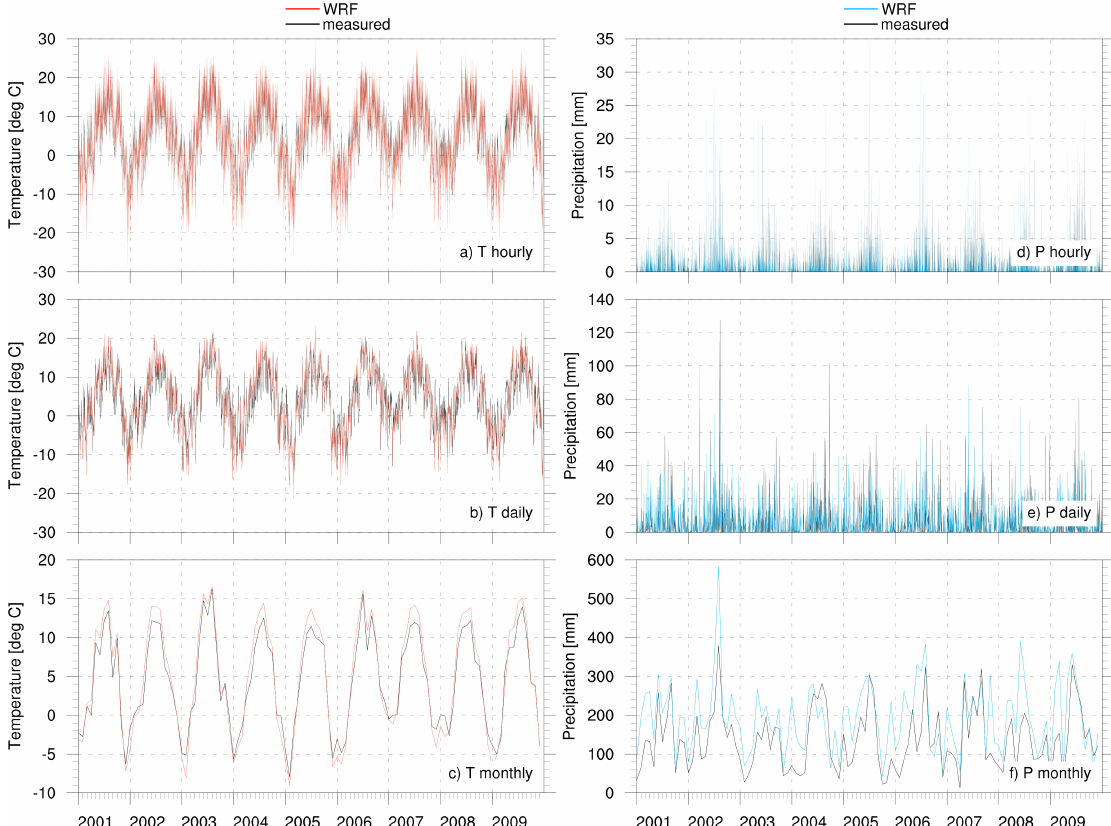
Figure 9. Temperature (left) and precipitation (right) modeled and measured at the station Loferer Alm (1623 m ASL) for the period 2001–2009. From top to bottom the panel shows hourly (top row), daily (center row), and monthly (bottom row) aggregated